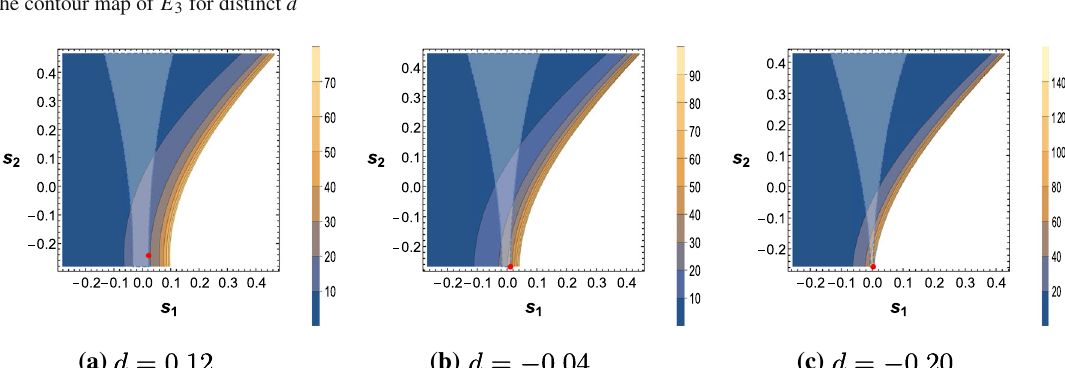
Fig. 4 The contour map of E 3 for distinct d